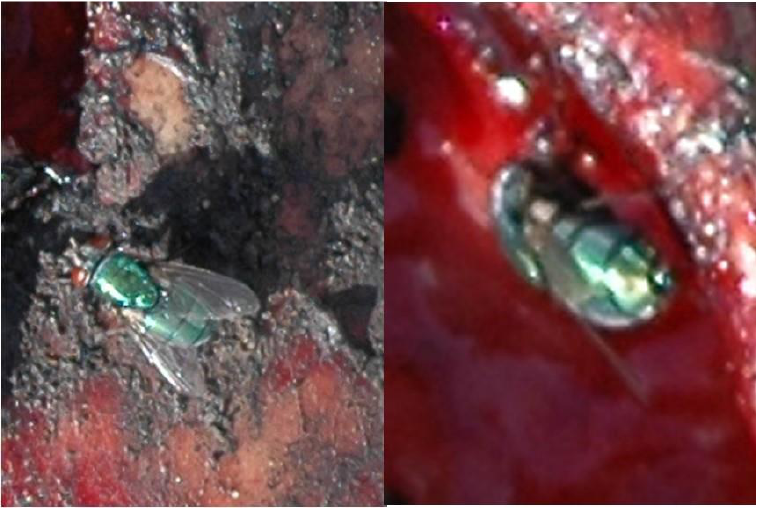
Figure 1. Photographs from graphic report by police